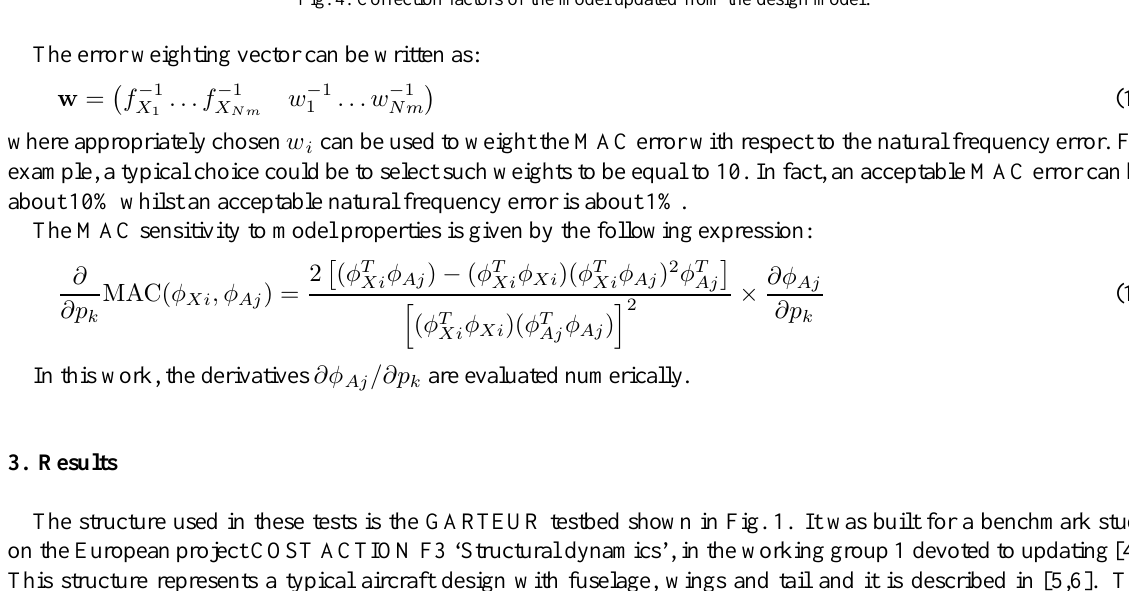
Fig. 4. Correction factors of the model updated from the design